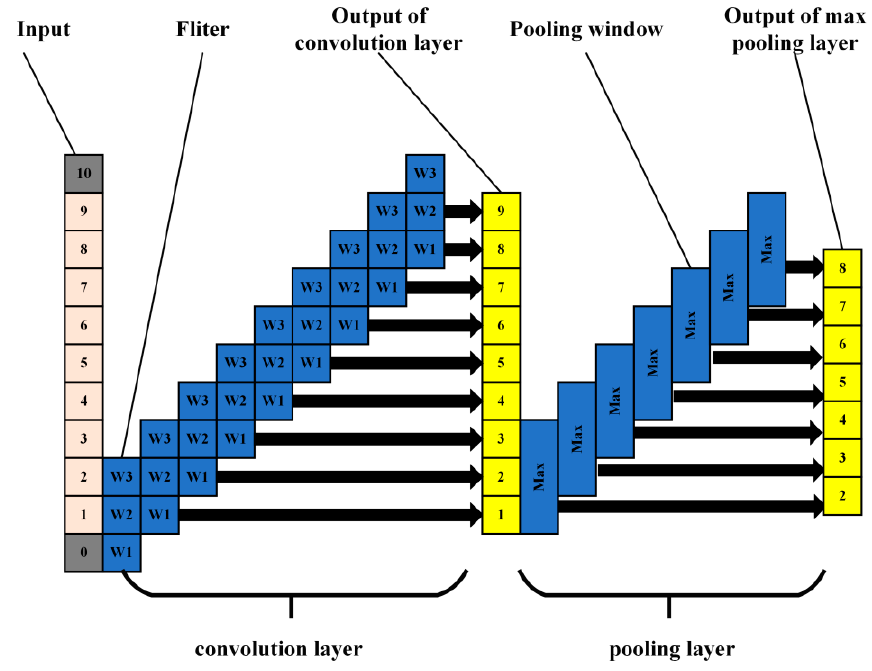
Figure 8. The schematic diagram of the one-dimensional CNN. (fliter denotes feature extractor, max denotes max pooling and wi denotes weigh matrix).